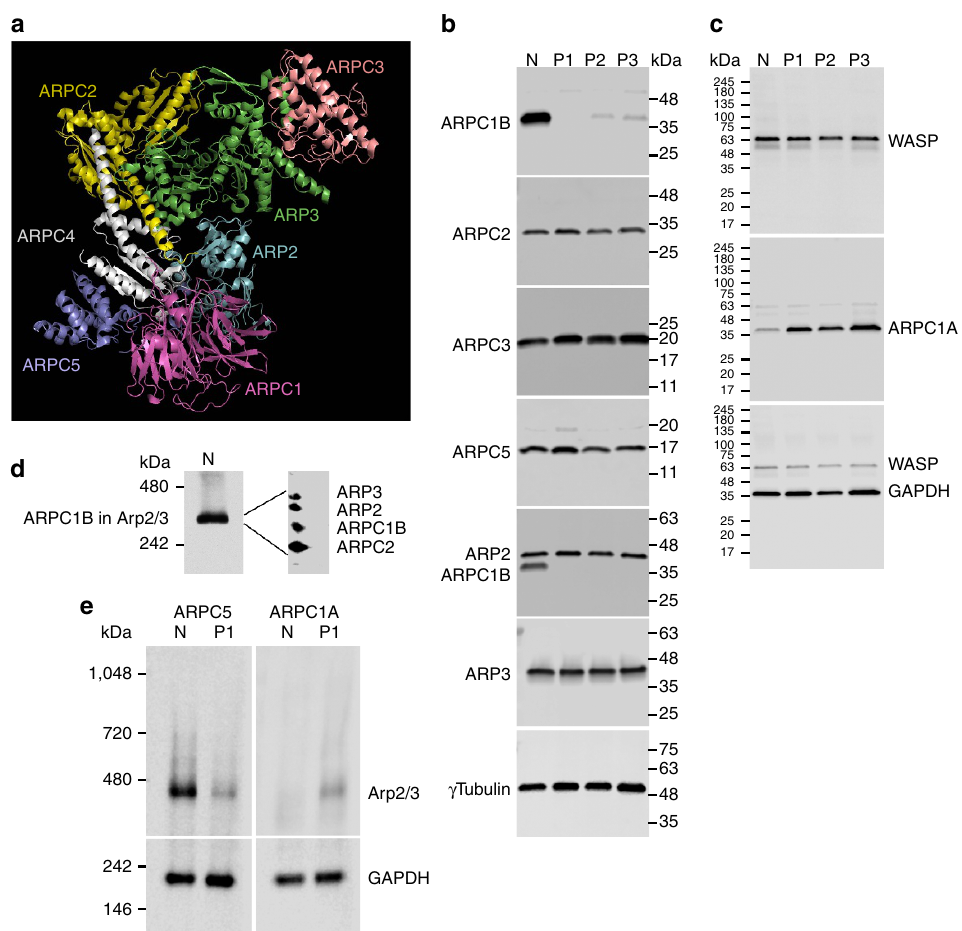
Figure 2 | ARPC1B and Arp2/3 complex are deficient in ARPC1B mutant platelets. ( a ) Crystal structure of mammalian Arp2/3 showing relative location of component proteins from the protein data bank (PDB1K8K, http://www.rcsb.org/pdb/explore/explore.do?structureId=1K8K; Robinson et al. 16 ). ( b ) Immunoblot analysis of platelet lysates showed ARPC1B to be absent in Patient 1 (P1) and greatly reduced in Patients 2 and 3 (P2, P3) compared to normal (N), while levels of ARPC2, ARPC3, ARPC5, ARP2 and ARP3 were normal (gamma tubulin used as loading control, see Supplementary Fig. 3a). ( c ) Platelet ARPC1A was increased in all three patients relative to normal, while WASP expression was equivalent (GAPDH used as loading control). ( d ) Immunoblot analysis of a normal platelet lysate after native gel electrophoresis showed a band corresponding to Arp2/3 complex detected by probing for ARPC1B (shown) or other Arp2/3 components (Supplementary Fig. 3d). This band was resolved on a second dimension SDS–PAGE gel, and immunoblotting confirmed the presence of Arp2/3 components (ARPC1B, ARPC2, ARP2 and ARP3 shown). ( e ) Immunoblotting of platelet lysates after native gel electrophoresis for ARPC5 (left) showed a greatly reduced level of Arp2/3 in Patient 1 (P1) platelets relative to normal (N). ARPC1A (right)